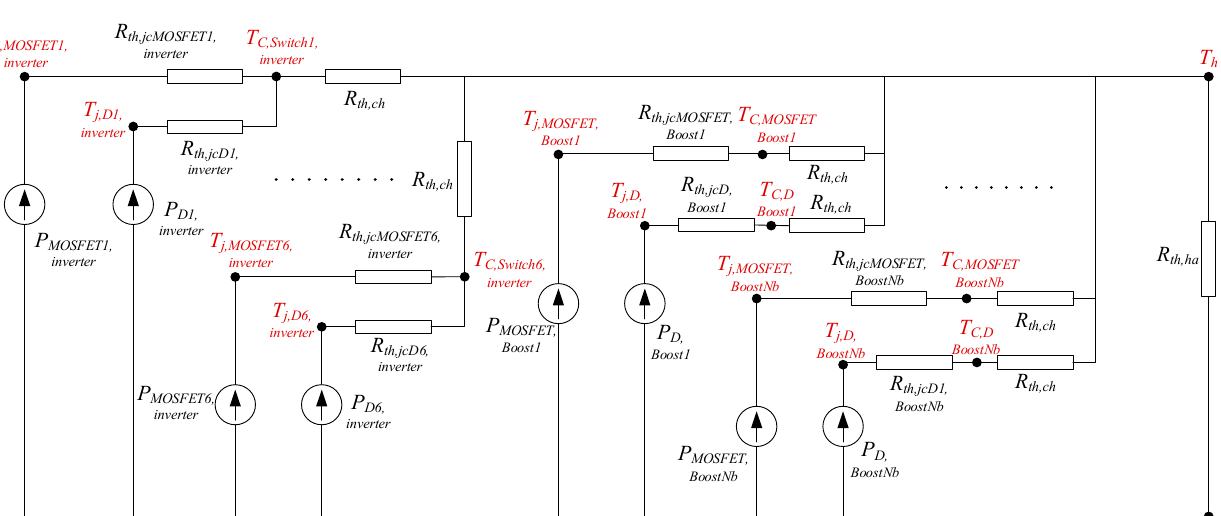
Figure 11. Thermal model of the case-studied photovoltaic inverter. Using the thermal model of Figure 11 allows for evaluating the temperatures of each device, being the input of reliability models. Furthermore, the maximum allowed temperature is the sizing constraint for the heatsink.